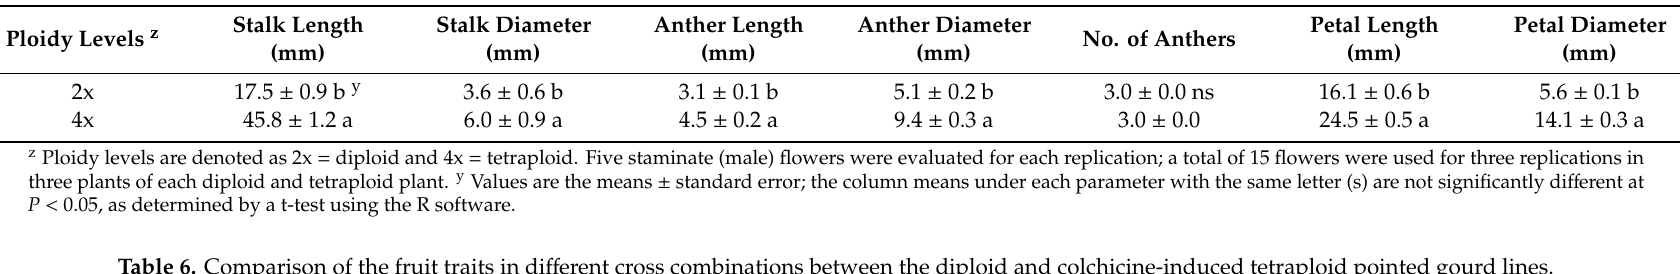
Table 6. Comparison of the fruit traits in di ff erent cross combinations between the diploid and colchicine-induced tetraploid pointed gourd lines. Cross Combination w (Seed Parent × Pollen